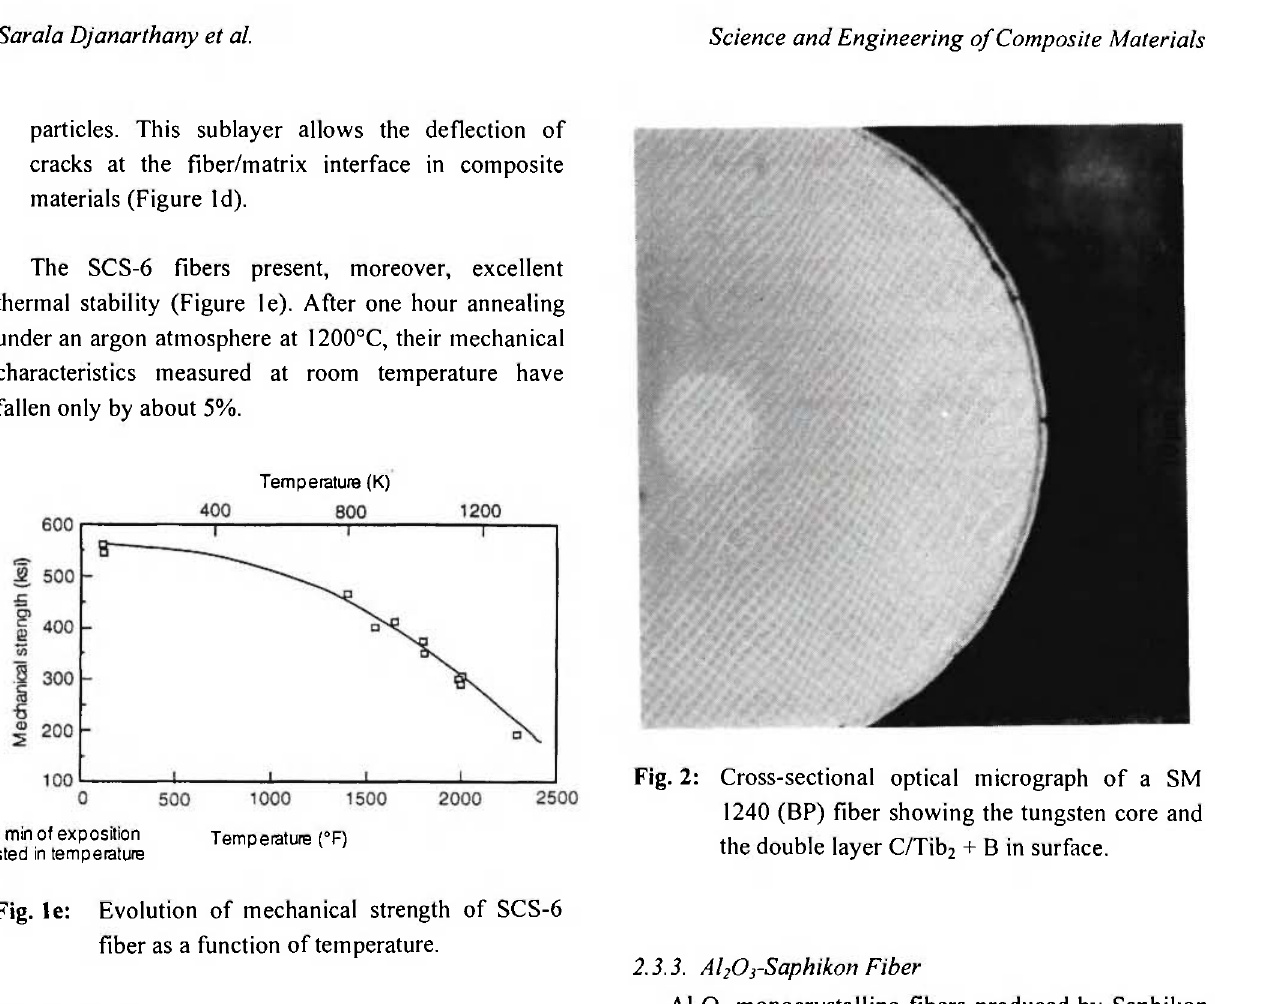
fibers are high